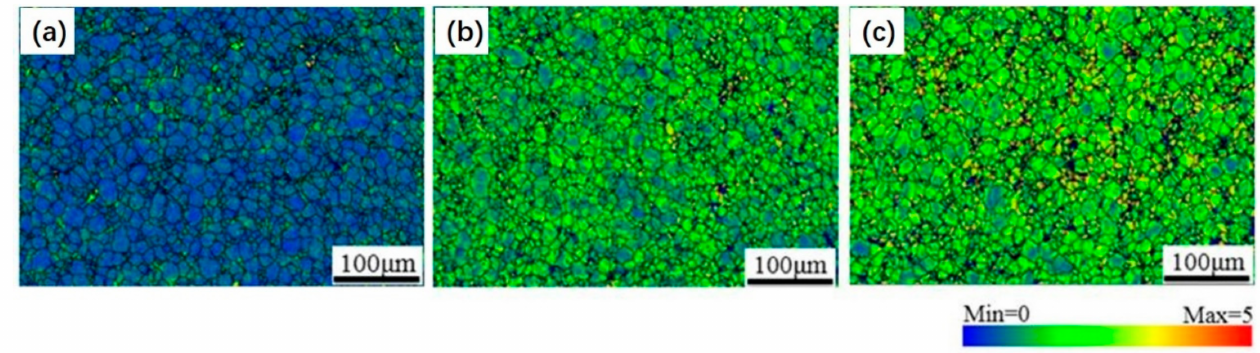
Figure 3. Local misorientation distributions of the twisted samples in the edge region ( a ) PT8, ( b ) PT28, ( c )